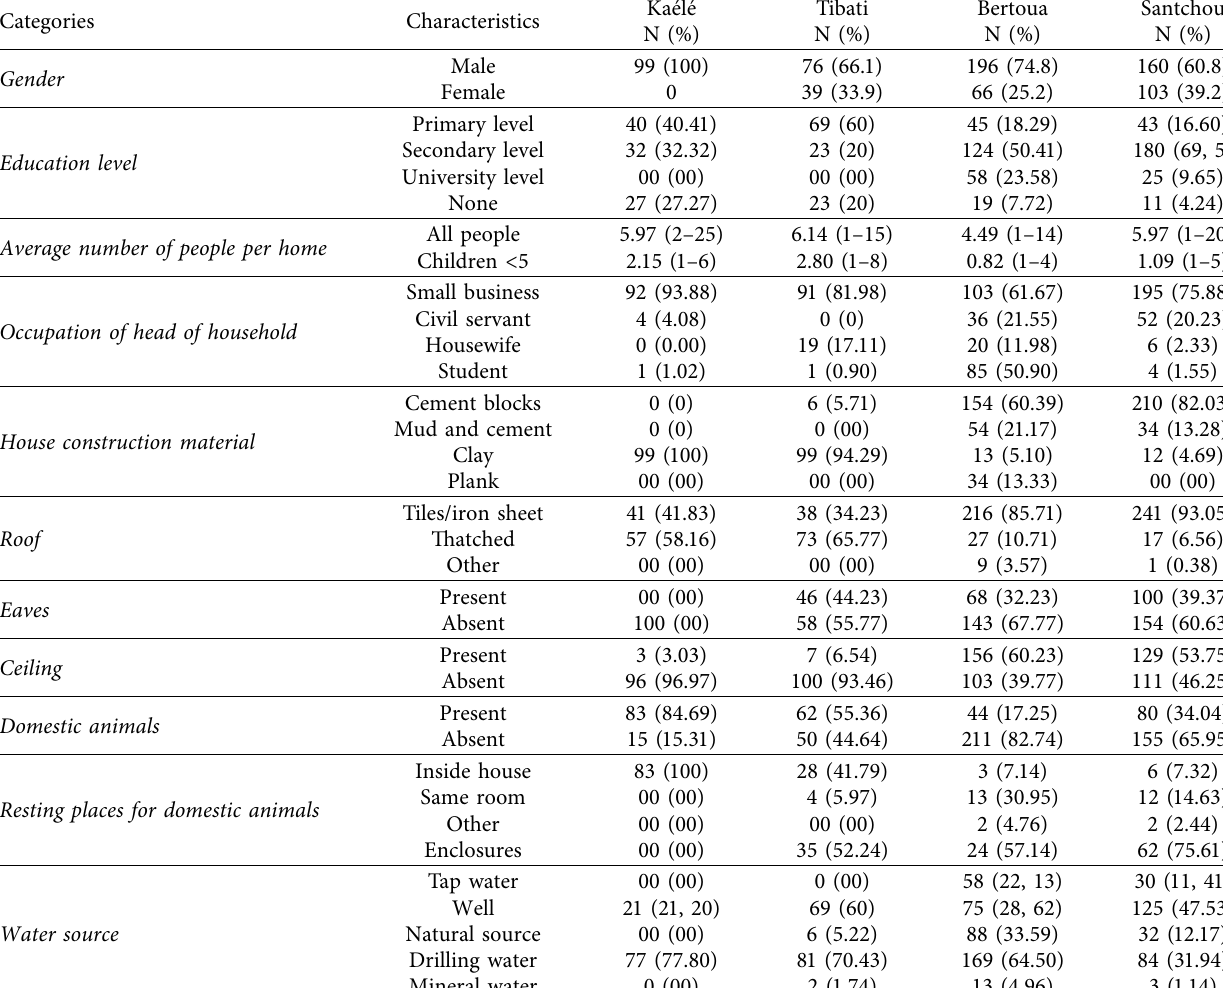
Table 2: Sociodemographic characteristics of households surveyed in Ka´el´e, Tibati, Santchou, and